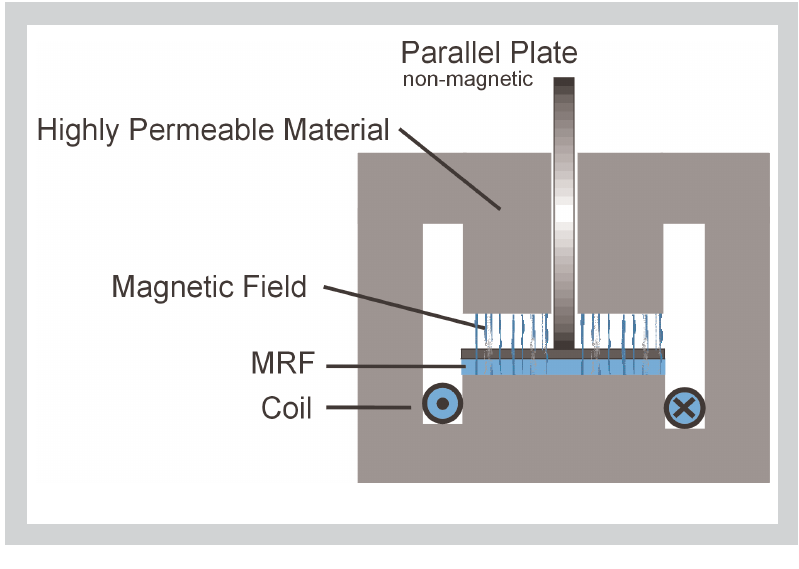
Figure 1 (above): Behavior of a MRF in the shear gap, before (left) and after the magnetic field is applied (right). Figure 2 (below): Principle of the magneto-rheological device (Physica MRD